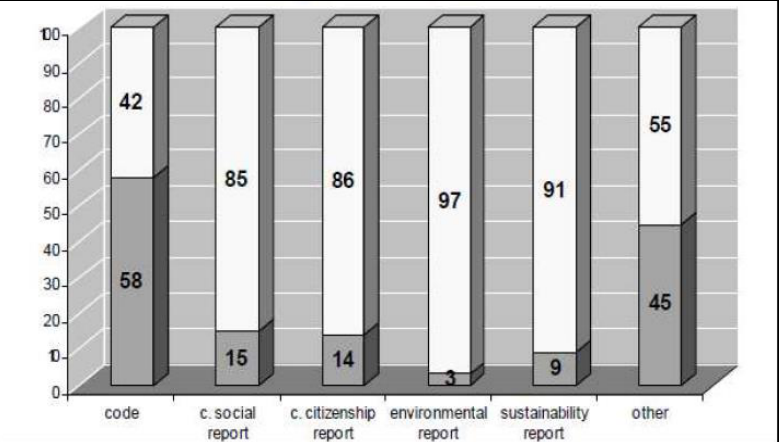
Figure 1: Percentage spread of corporate governance communication